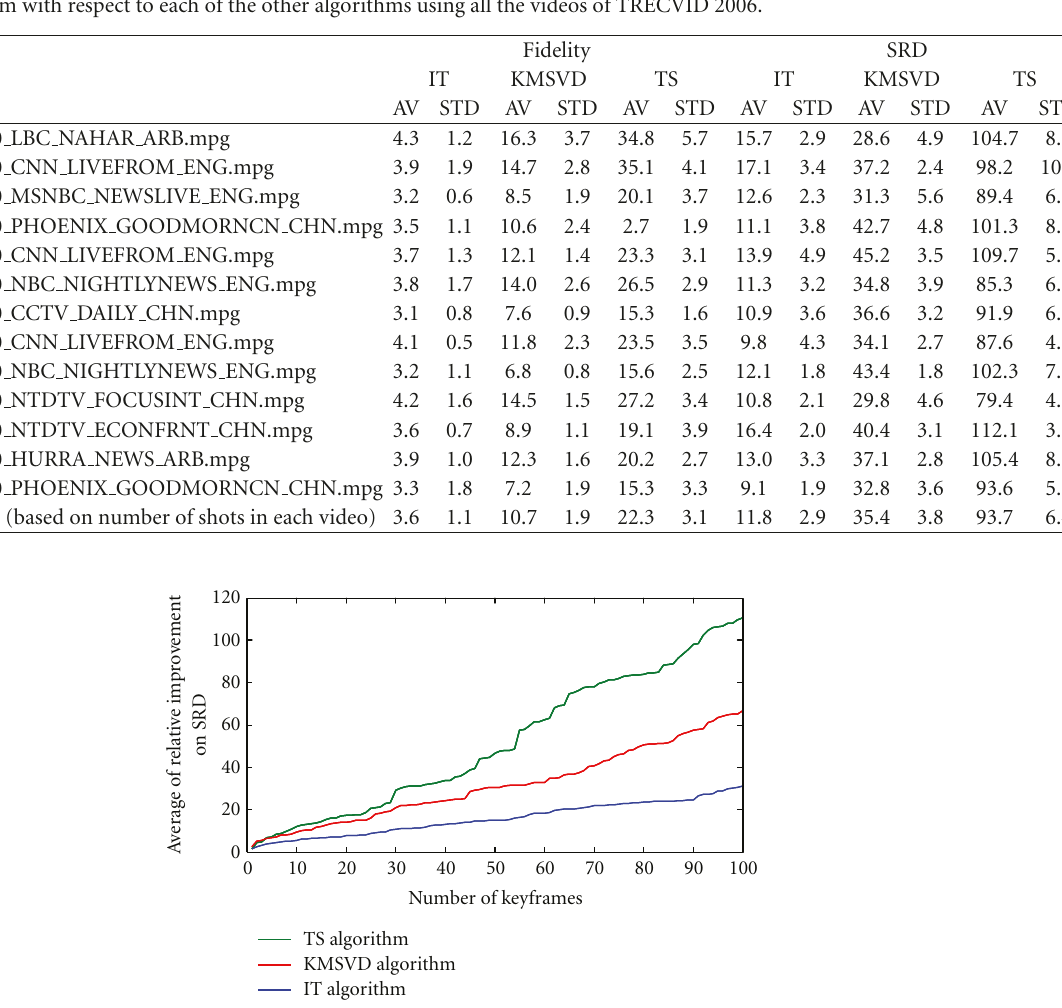
Figure 7: The average of relative improvement of SRD (the results are in percentages).